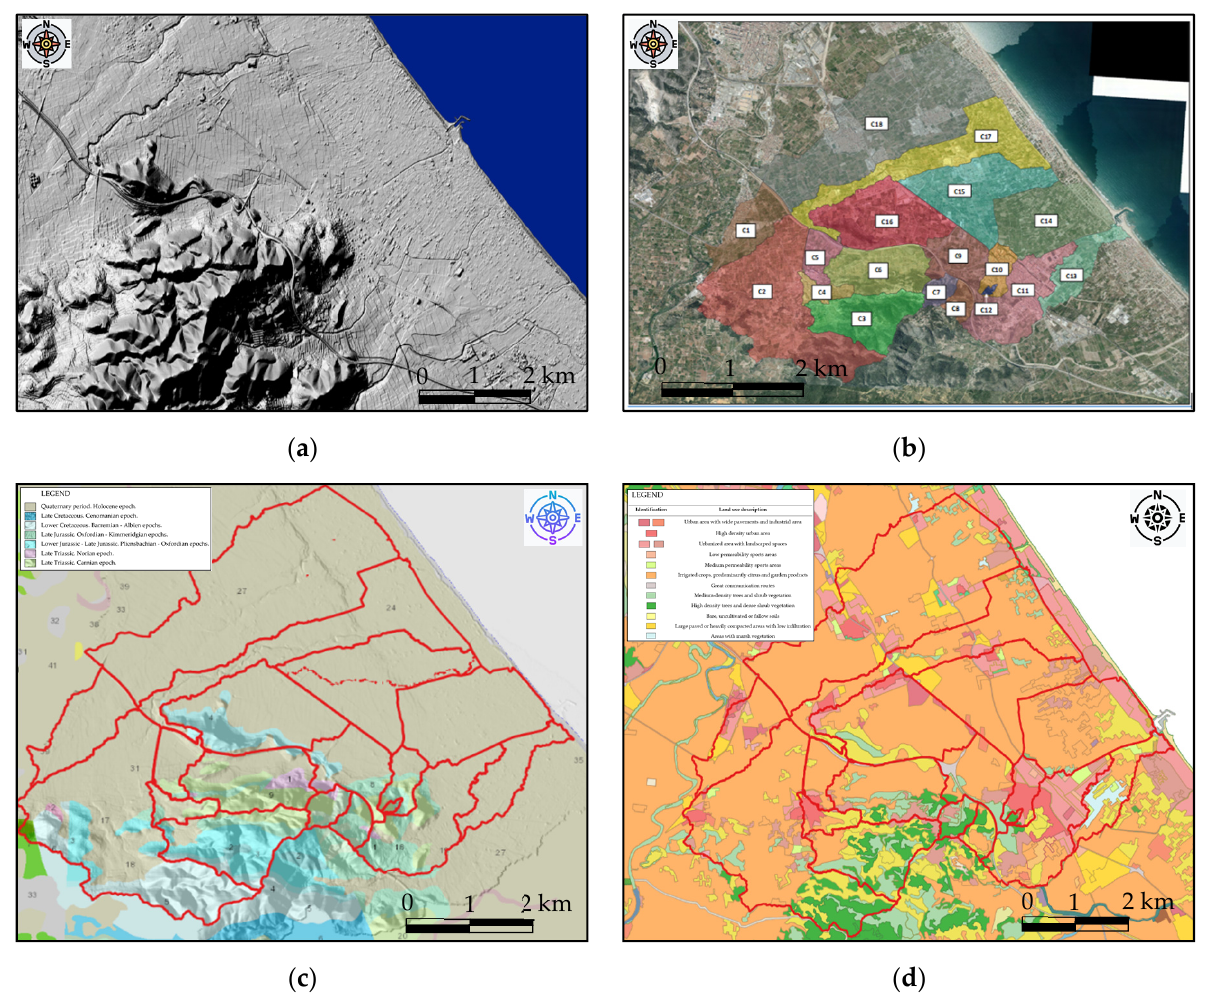
Figure 4. Territory analysis of the area under study: ( a ) DEM; ( b ) division of the area into sub-basins; ( c ) sub-basins defined overlapped with the geological epoch-period and orography; ( d ) land uses of SIOSE map [25]. All maps are oriented to the North. An extended larger version of Figure 4b–d, can be found in the Supplementary Material. Table 1. Sub-basin areas and their centroid elevation. Description gives the local name of the riv- erbed; note that the same riverbed is sometimes named with different local names through its run (e.g., C3, C6, C9, and C14 correspond to the same riverbed).